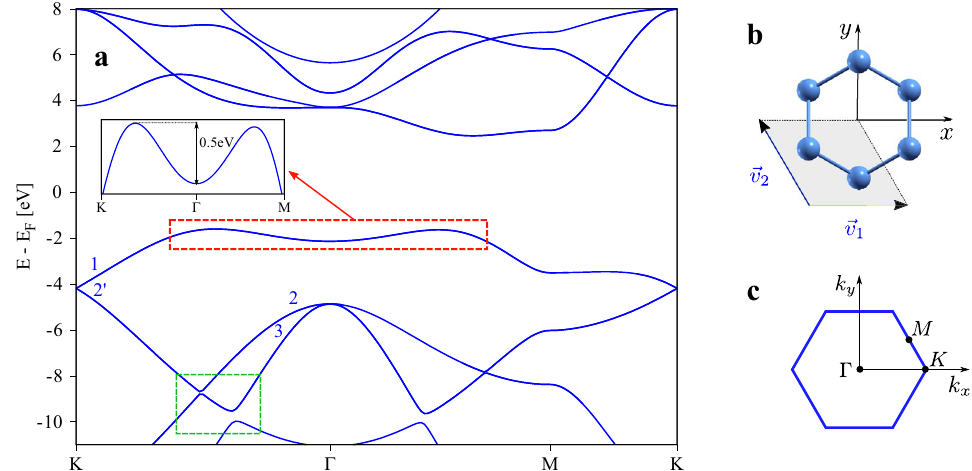
Figure 1. Electronic properties of monolayer nitrogene: ( a ) Calculated relativistic band structure of nitrogene plotted along high symmetry lines of the First Brillouin Zone shown in ( c ). The inset enlarges the valence band around the Ŵ point. The two maxima lie approximately 0.5 eV above the minimum at the Ŵ point; ( b ) crystalline structure of 2D nitrogene with the lattice vectors v 1 , v 2 , | v | = 0.69 Å and the unit cell marked by the shaded area; ( c ) The First Brillouin Zone of 2D nitrogene with depicted high symmetry